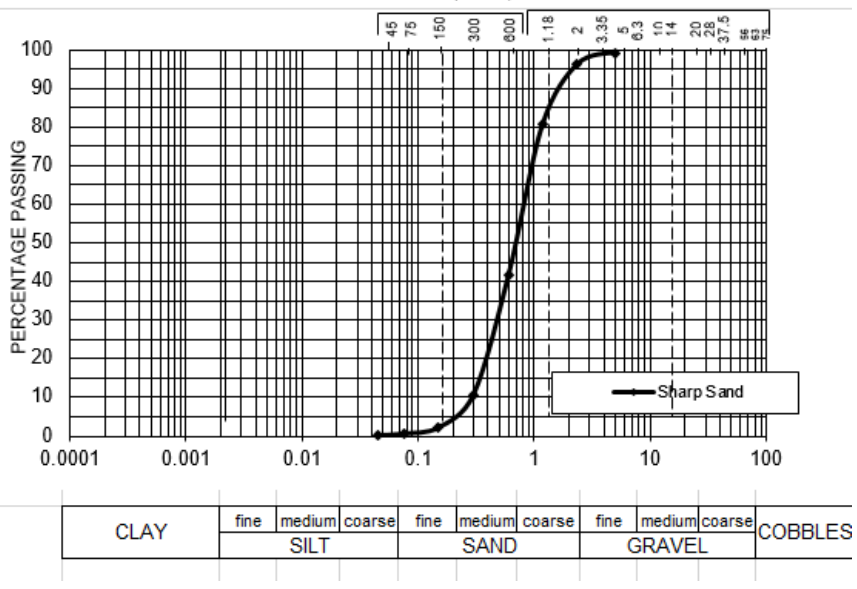
Figure 1. Particle size distribution curve for